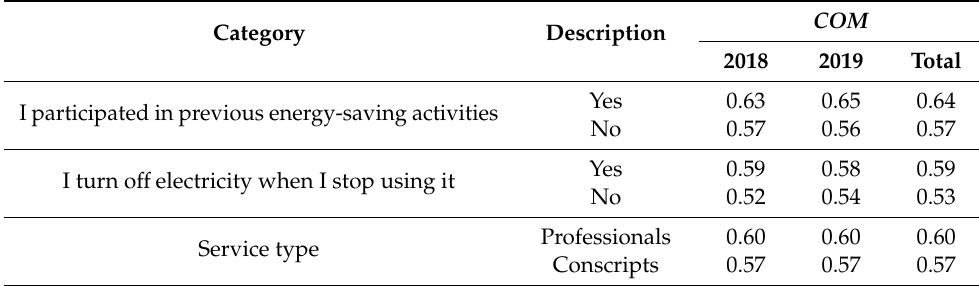
Table 3. Comparison of Capability-Opportunity-Motivation ( COM) values for different groups of respondents.